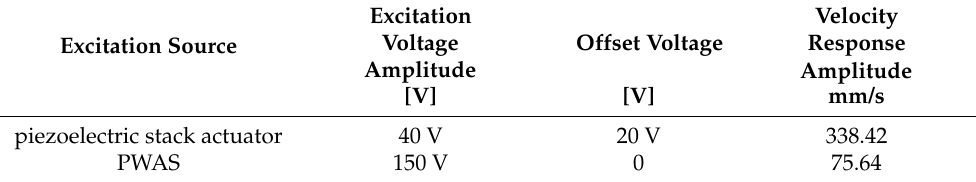
Figure 6. Dynamic out-of-plane velocity response to a sinusoidal excitation at the local resonance frequency f 0 = 5.641 kHz for considered excitation sources and scan point at the debonding center. Table 1. Summary of maximum dynamic out-of-plane velocity response to a sinusoidal excitation at the the local resonance frequency f 0 = 5.641 kHz for selected excitation sources and scan point at debonding